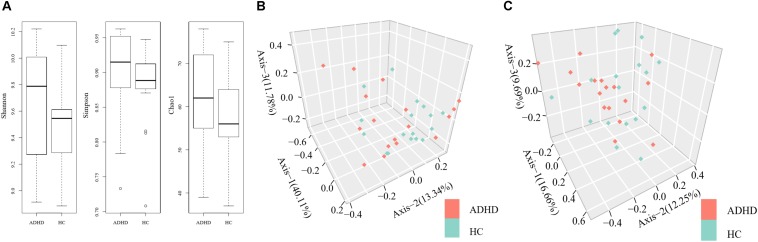
(A) Comparison of alpha diversity indexes between the ADHD and HC groups. (B) Permutational multivariate analysis of variance (PERMANOVA) of microbial communities of the participants at the genus level. (C) PERMANOVA of microbial communities of the participants at the species level.